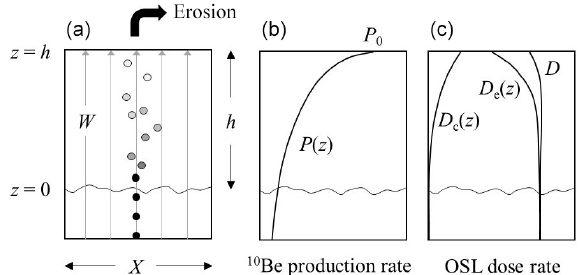
Figure 2. Schematic diagram of (a) soil element with dimensions XYh . Particles move from the soil–saprolite interface ( z = 0) into the element at a steady rate W and are eroded from the surface ( z = h ). Particles experience a mean motion (gray arrows) with su- perimposed mixing motions. (b) in situ 10 Be production rate P ( z ). (c) idealized luminescence dose rate D as the sum of the external rate D e ( z ) and the contribution from cosmic rays D c ( z ). Compare with Fig. 1 in Mudd and Yoo